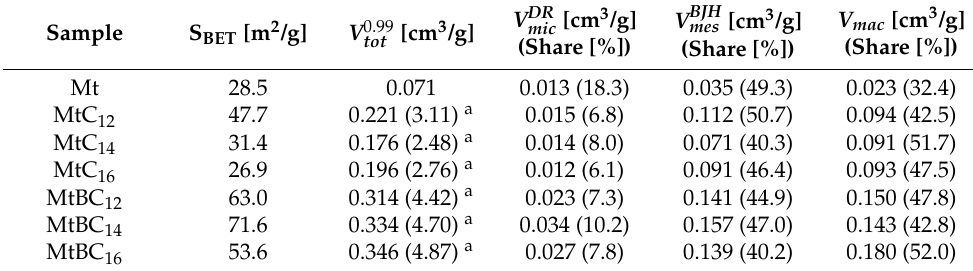
Table 1. The textural parameters of raw and intercalated montmorillonites.